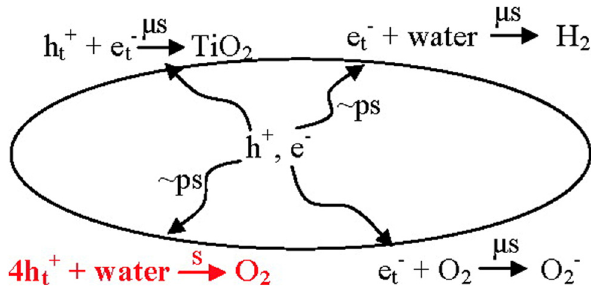
Figure 1: Schematic of the TiO 2 photocatalytic water - splitting me - chanism, reprinted with permission from ref. [ 77 ] , Copyright ( 2008 ) American Chemical